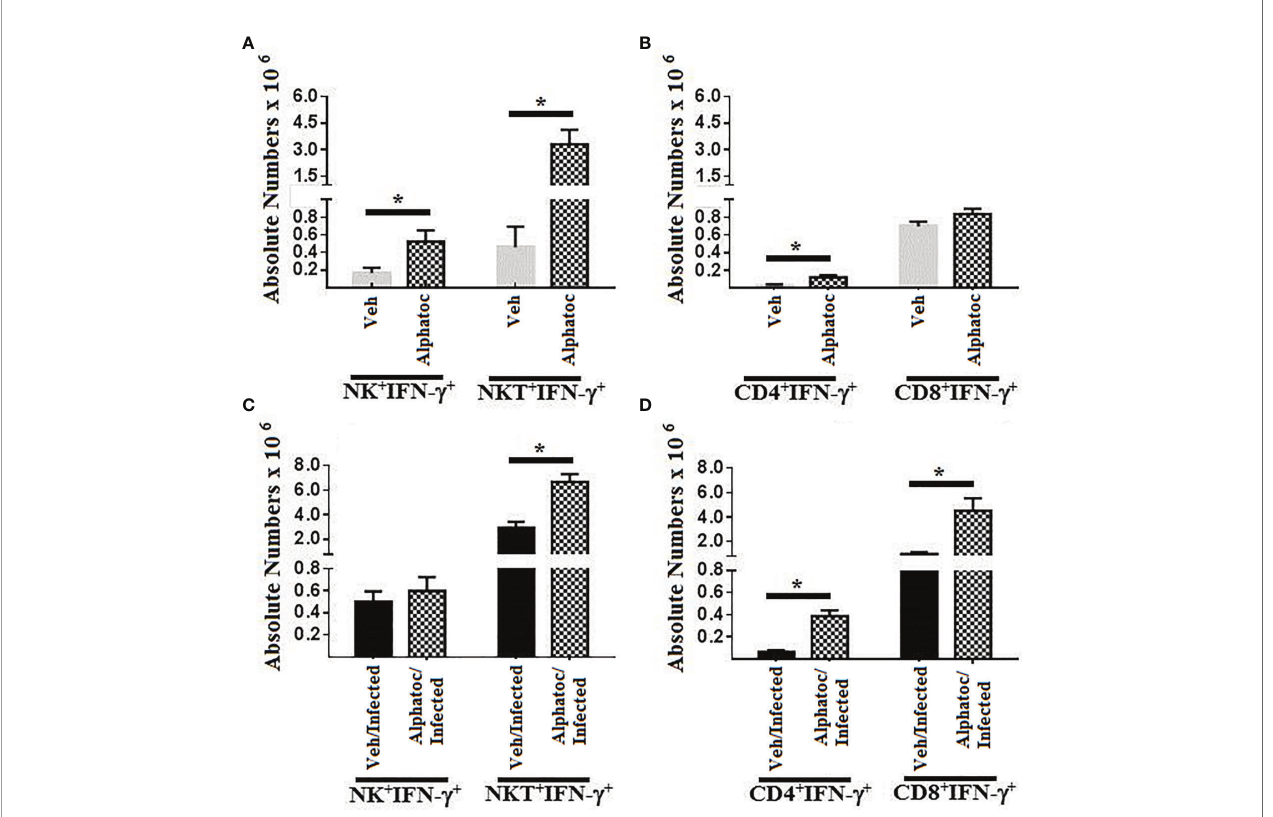
FIGURE 2 | IFN- g production by NK and T cell splenocytes. In (A) , IFN- g -producing NK and NKT cells in uninfected animals pretreated with vehicle or alphatoc were compared. (B) , CD4 or CD8 T cell splenocytes producing IFN- g are shown in the vehicle or alphatoc pretreated animals. In (C) , NK and NKT cells producing IFN- g are shown. The alphatoc/infected group was individually compared to the other groups. In (D) , the alphatoc/infected group was individually compared to the other groups (*P < 0,05, Mann Whitney test, n=4). Data are for one representative experiment out of